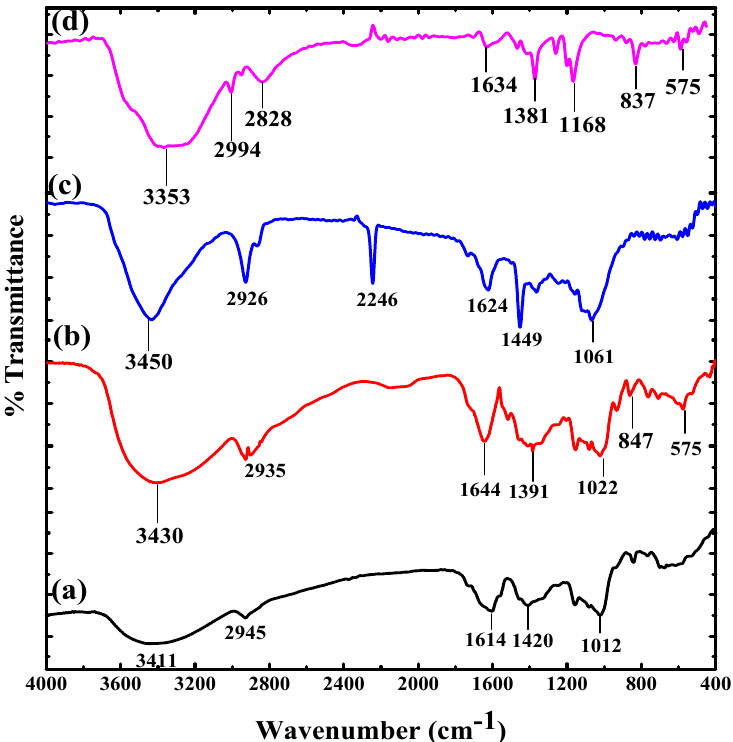
Figure 1. FTIR spectra of: ( a ) sodium alginate; ( b ) Alg@Ag NPs; ( c ) poly(acrylonitrile); and ( d ) PAN- g-Alg@Ag.